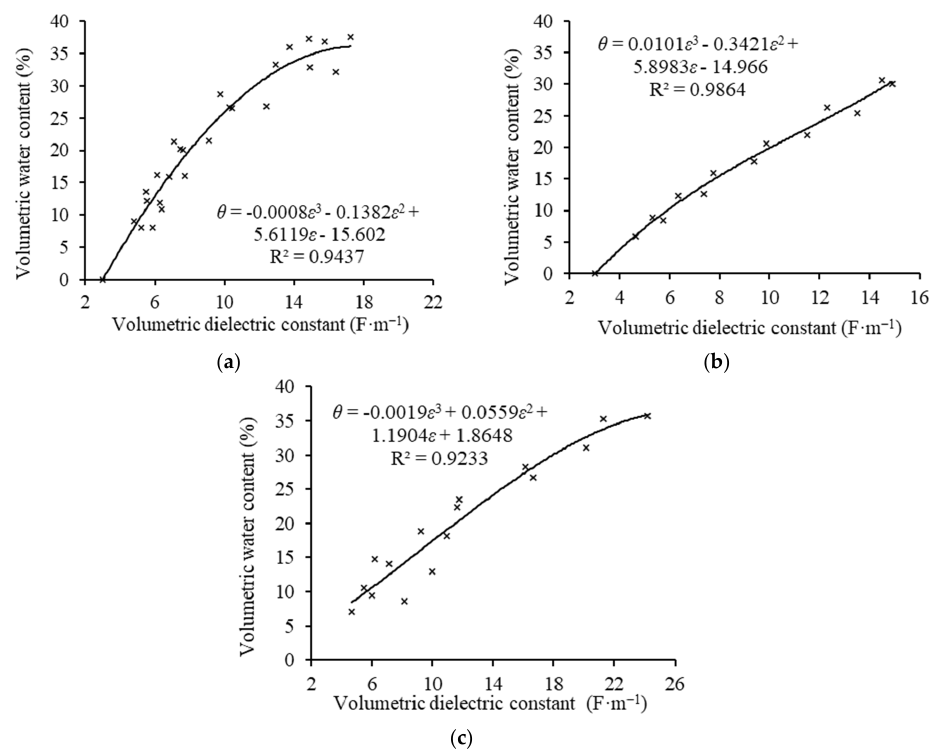
Figure 4. Corrected curves of moisture content of di ff erent lithologies. ( a ) Loam; ( b ) Sandy loam; ( c ) Silty sands.